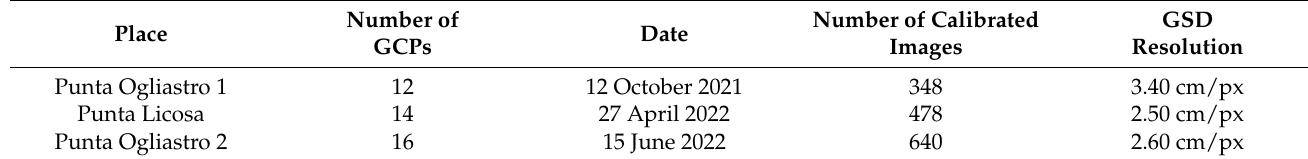
Table 1. Image acquisition